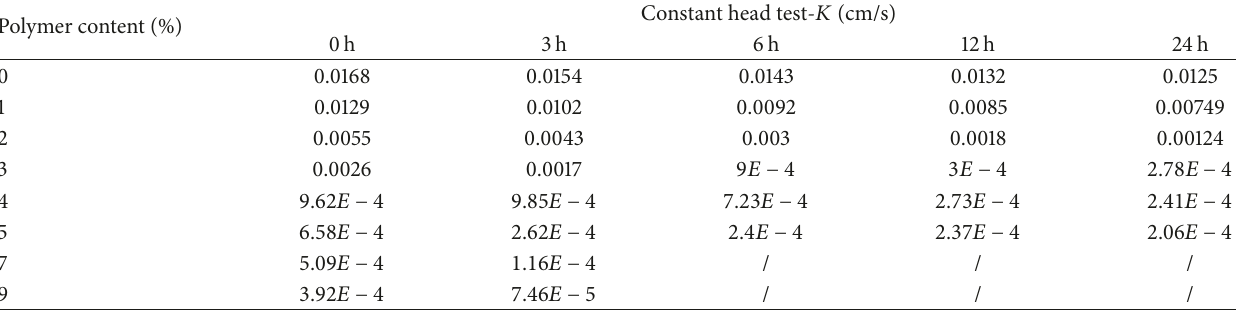
Table 2: The permeability coefficient ( 𝐾 ) calculated from penetration test.